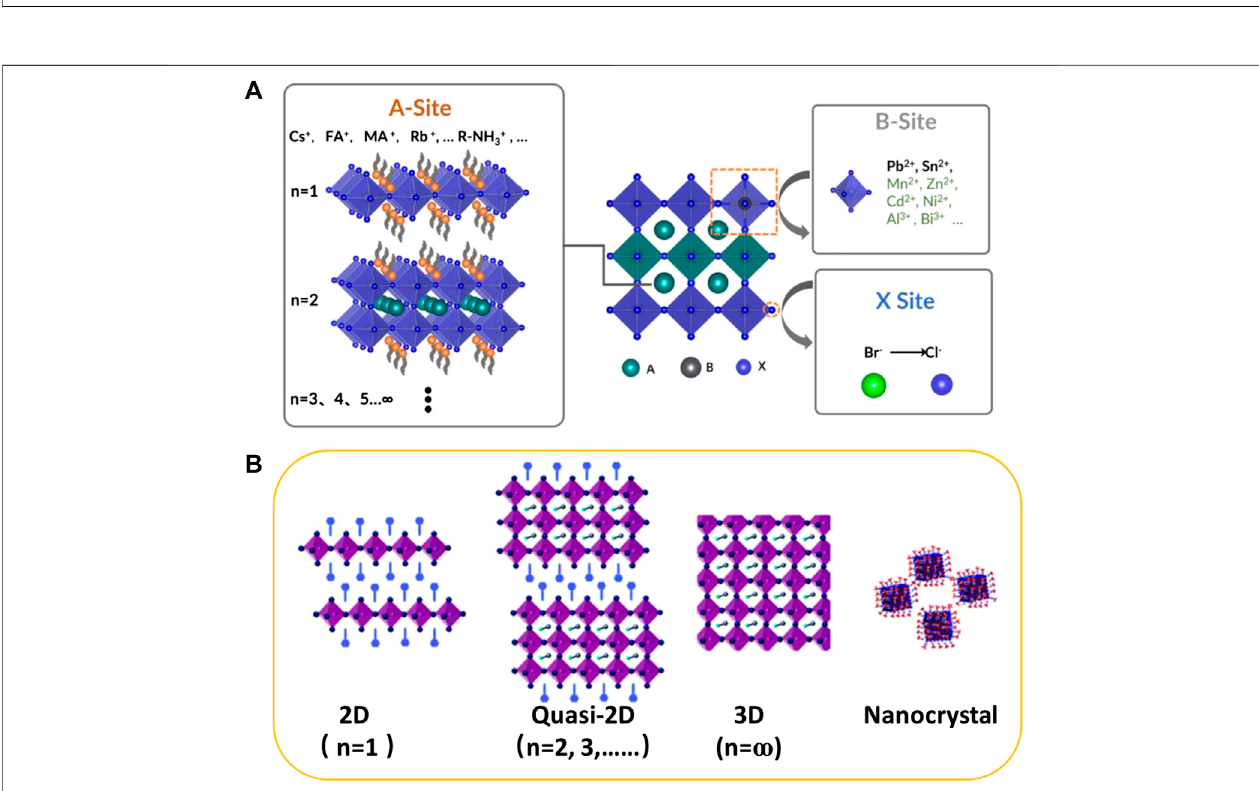
FIGURE2|(A) SchematicillustrationdescribingtheregulationofA-,B-andX-siteatomsoftheperovskitetoachieveblueluminescence. (B) Structurediagramsof 2D, quasi-2D, 3D perovskite and perovskite nanocrystal for dimensional engineering of